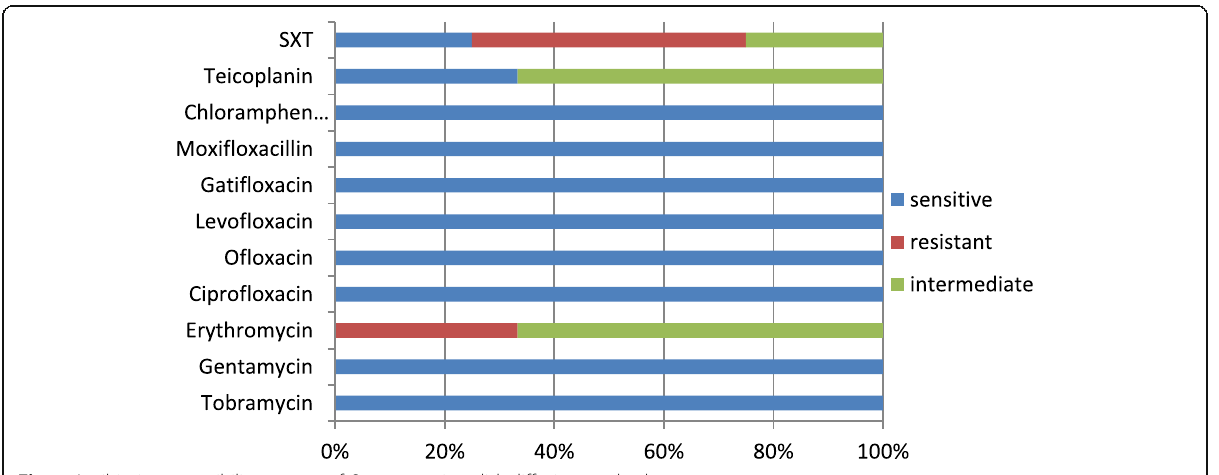
Fig. 5 Antibiotic susceptibility pattern of S. aureus using disk diffusion